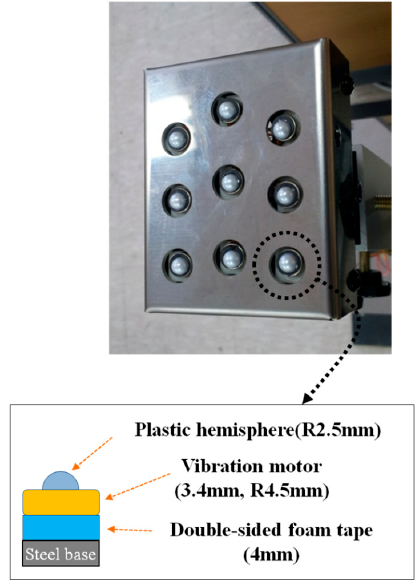
Figure 10. Configuration of the tactile display.